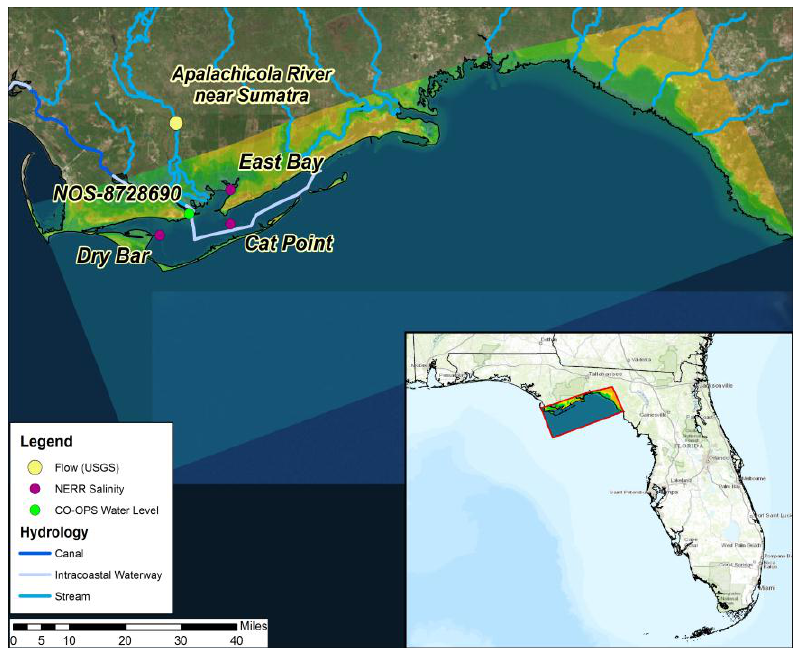
Figure 1. Apalachicola Bay system, data stations and Curvilinear-grid Hydrodynamics in 3D (CH3D) model grid (outlined in red).